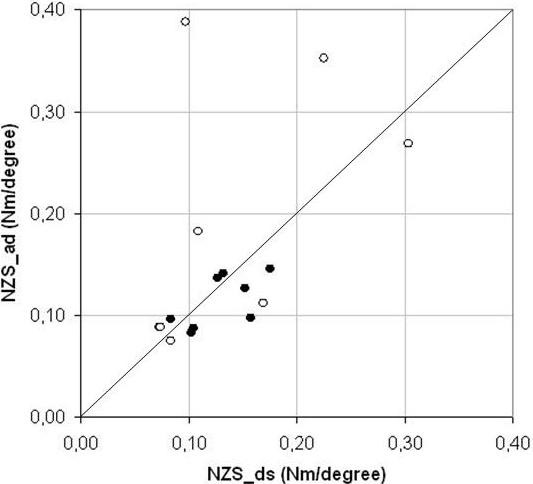
Scatter plot of the Neutral Zone stiffnesses. The NZ stiffness calculated by the double sigmoid function (NZS_ds, x-axis) as compared to the angulation difference as defined by Wilke (NZS_ad, y-axis). The stiffness appears to be more consistent before preloading (closed circles) as compared to after preloading (open circles). Note the three outliers from the loaded segments. The thin line represents identity.